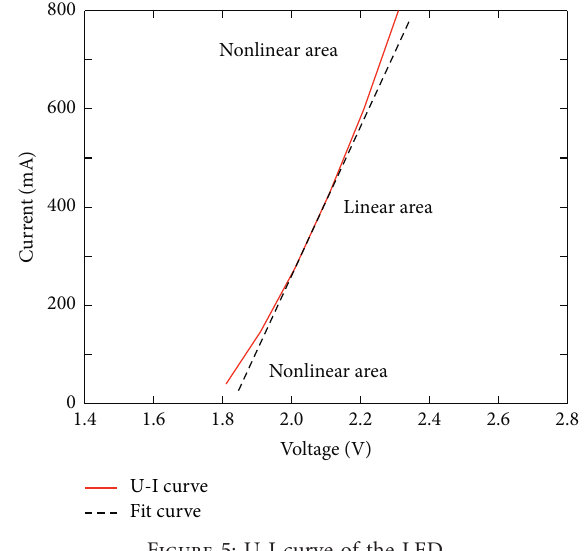
Figure 5: U-I curve of the